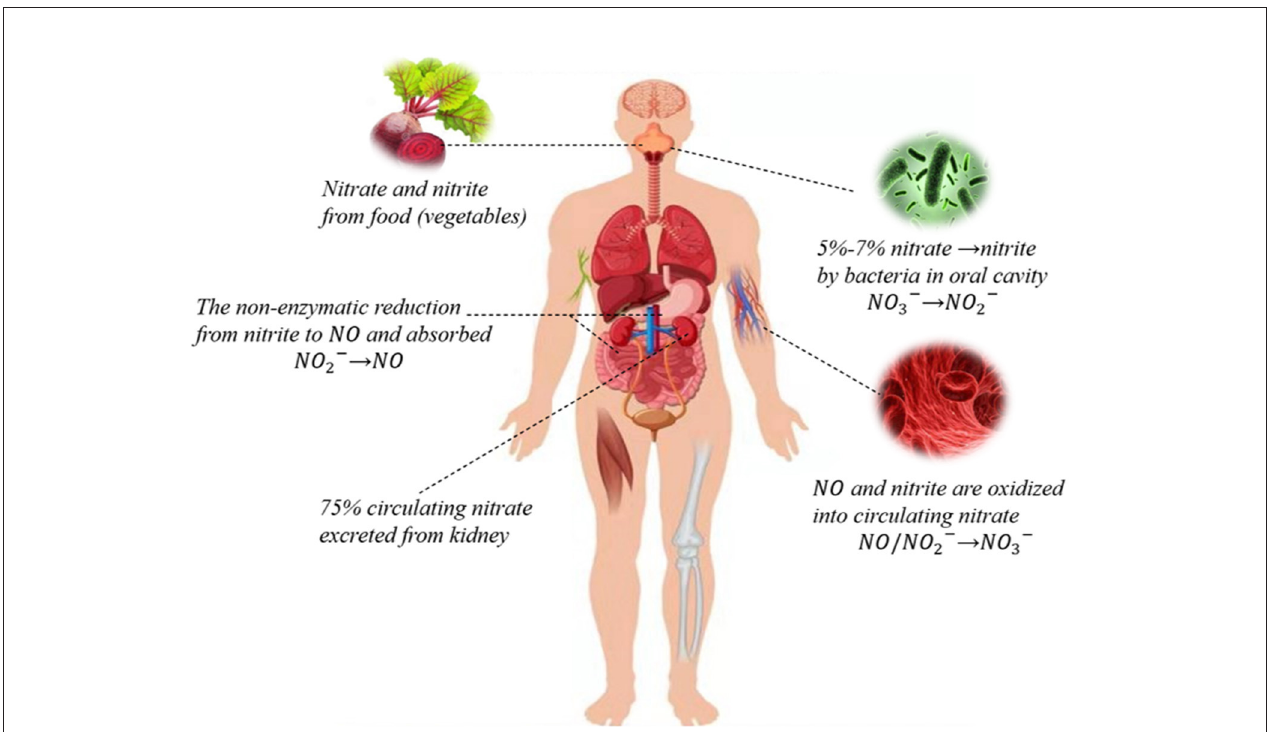
FIGURE 1 | Nitrate-nitrite-NO pathways in humans. Nitrate circulating in the body is mainly derived from the dietary intake of green leafy vegetables, while a small portion of endogenous nitrate is mostly derived from oxidation reactions. Dietary nitrate is converted into nitrite by symbiotic facultative anaerobes in the oral cavity. Nitrite can be reduced to NO and both can be oxidized to nitrate. About 75% of circulating nitrate is excreted through urine, and the rest is reabsorbed through the kidneys and bile ducts or absorbed by the salivary gland that is secreted into saliva through sialin or other nonspecific transport